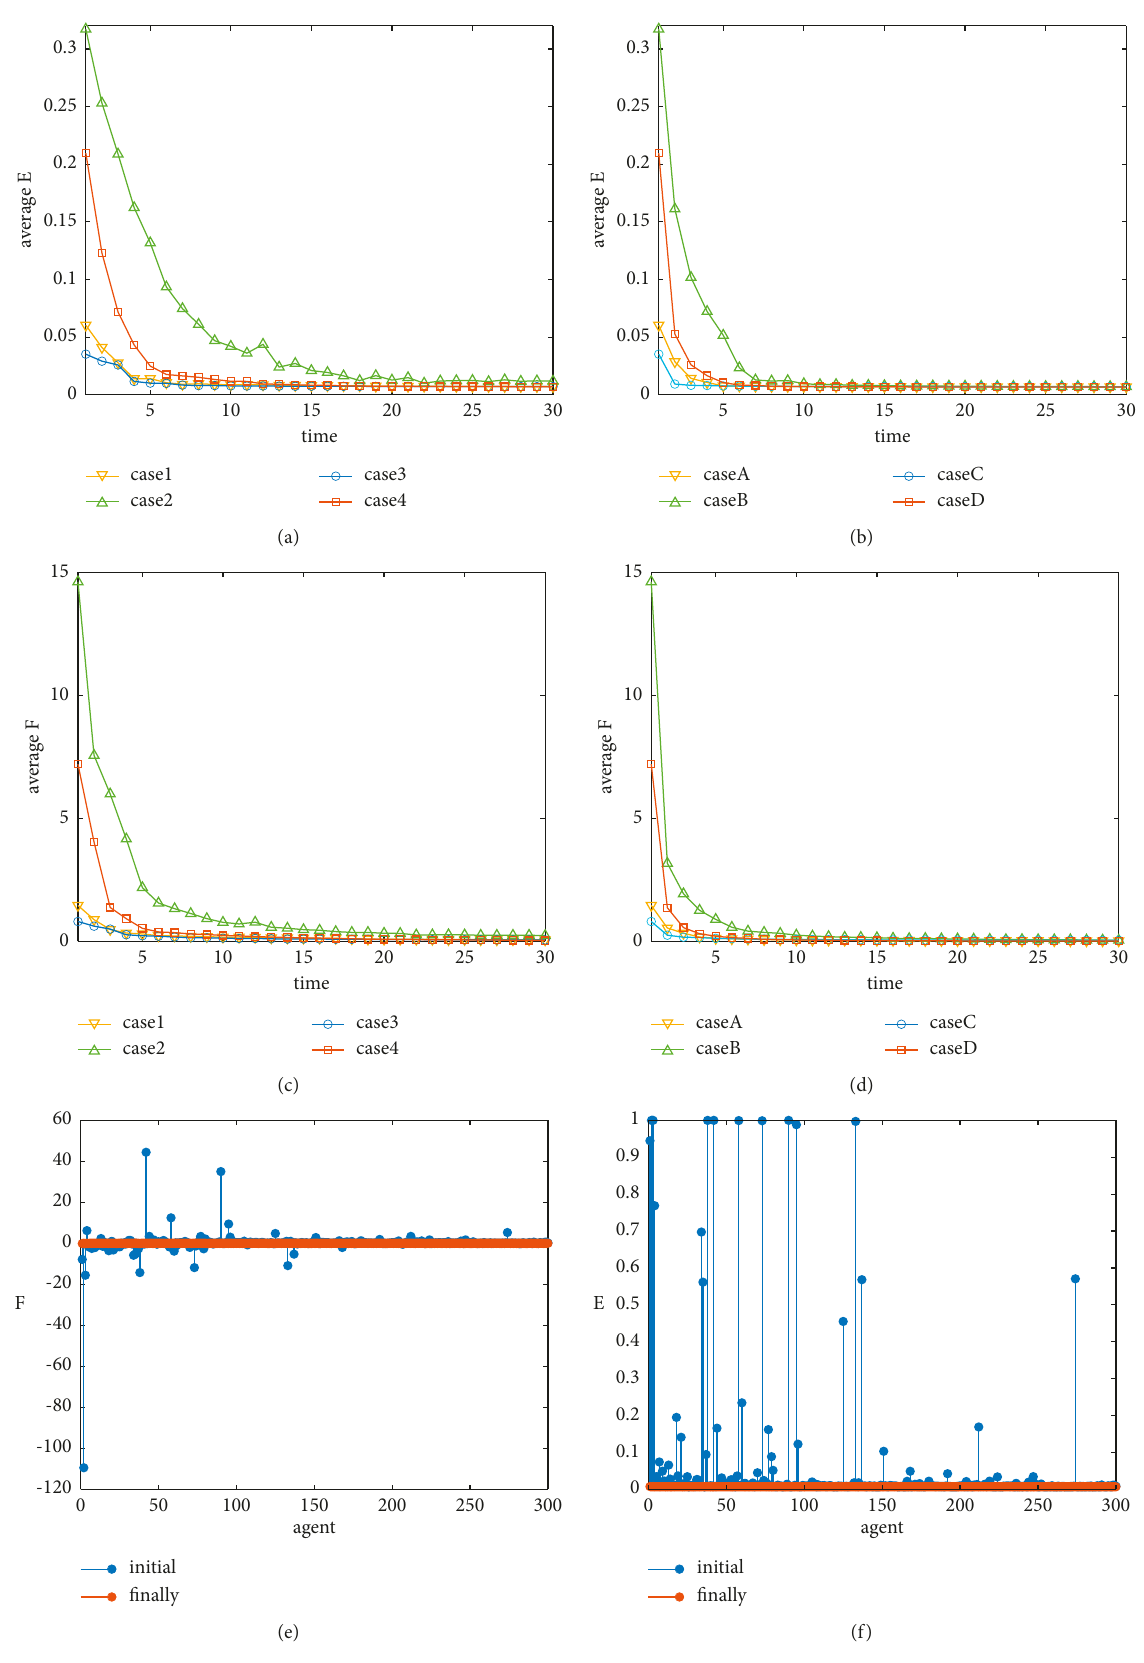
Figure 7: Comparison of the public opinion pressure (a, b). The average F of different cases (c, d). The average E of different cases (e). The F of each agent, the blue stems show the initial F , and the red stem shows the final F after once opinion evolution in case 1 (f). The E of each agent, the blue stems show the initial E, and the red stem shows the final E after once opinion evolution in case